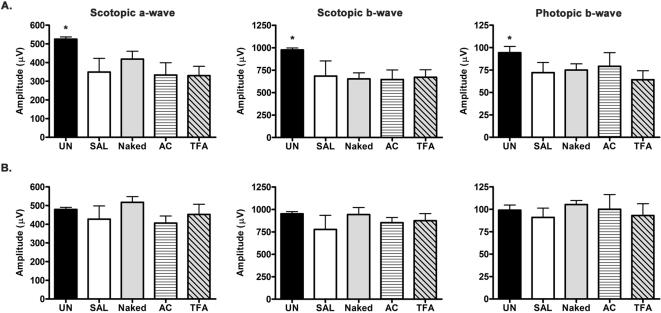
Assessment of retinal function following subretinal injection.ERG analyses were performed in adult Balb/c mice (n = 4) after 7 and 30 days following subretinal delivery of 1 uL saline, naked plasmid, AC-GFP, or TFA-GFP and compared to uninjected controls (UN).To assess rod photoreceptor function and signal transmission scotopic ERG was performed on dark-adapted mice and photopic ERG was performed light-adapted mice to assess cone photoreceptor function.
(A) At 7 days post-injection, a significant decrease from WT amplitudes was observed in all injected eyes (p<0.05) as an immediate consequence of the injection procedure and subsequent retinal detachment, however there was no significant difference among any of the experimental groups (p>0.05) in the scotopic and photopic amplitudes.
(B) By 30 days post-injection, no significant difference in scotopic and photopic amplitudes was observed between WT and injected groups (p>0.05), demonstrating the lack of toxicity associated with nanoparticle-transfection in photoreceptors.Significance was determined with ANOVA and Bonferroni's pair-wise comparison test.